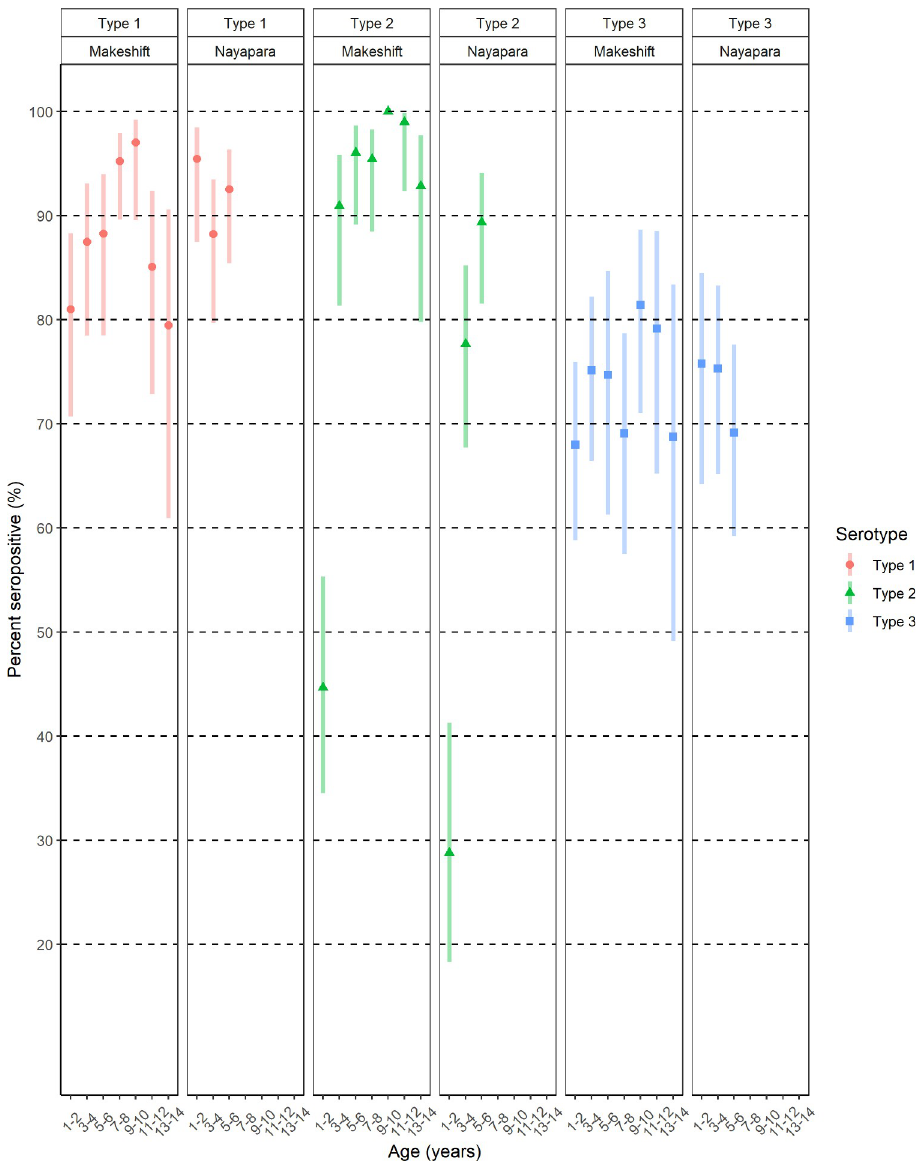
Fig 2. Seroprevalence to poliovirus by serotype, camp/settlements, and age (2-year intervals)—Rohingya children in Cox’s Bazar, Bangladesh, April–May 2018. Data presented as percent seropositive and Wilson 95% confidence